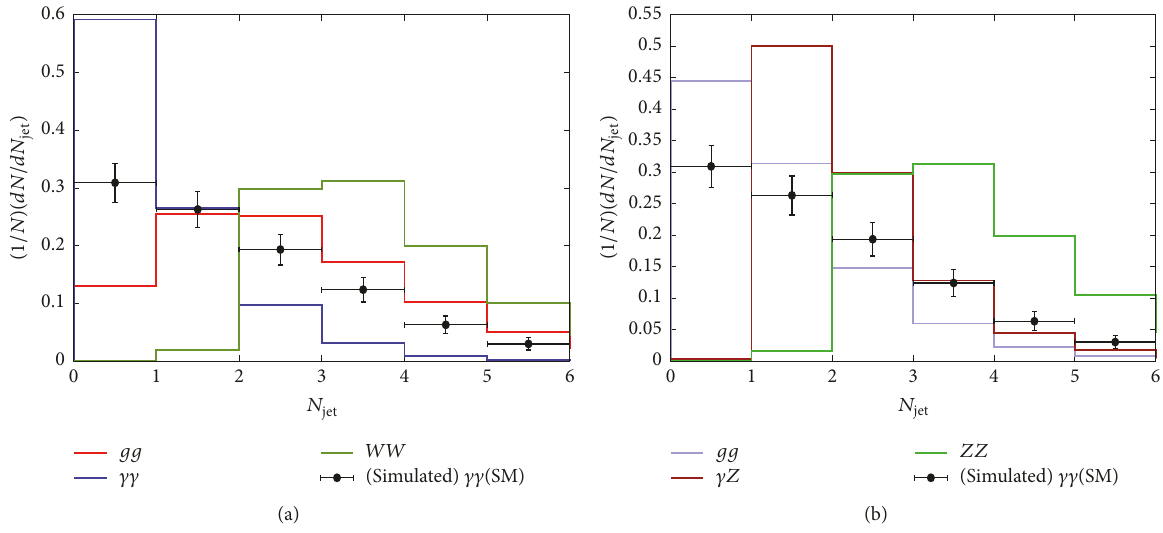
Figure 6: Jet multiplicity ( 𝑁 jet ) distributions of various production modes of the scalar Φ for 𝑀 Φ = 1 TeV at the 13TeV LHC. The 𝑁 jet distribution for the dominant SM background, that is, for the 𝑝𝑝 → 𝛾𝛾 process, is obtained from our simulation. The uncertainty associated with this distribution is statistical uncertainty only which is computed for L = 50 fb −1 .